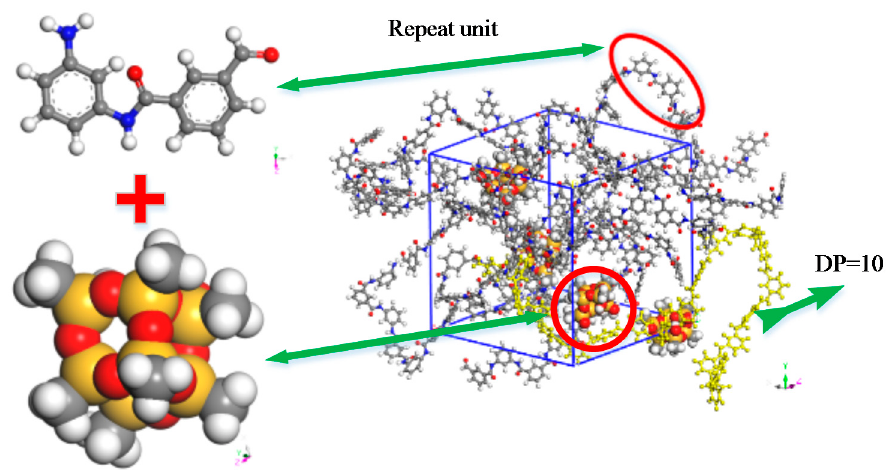
Figure 1. Schematic diagram of composite model.